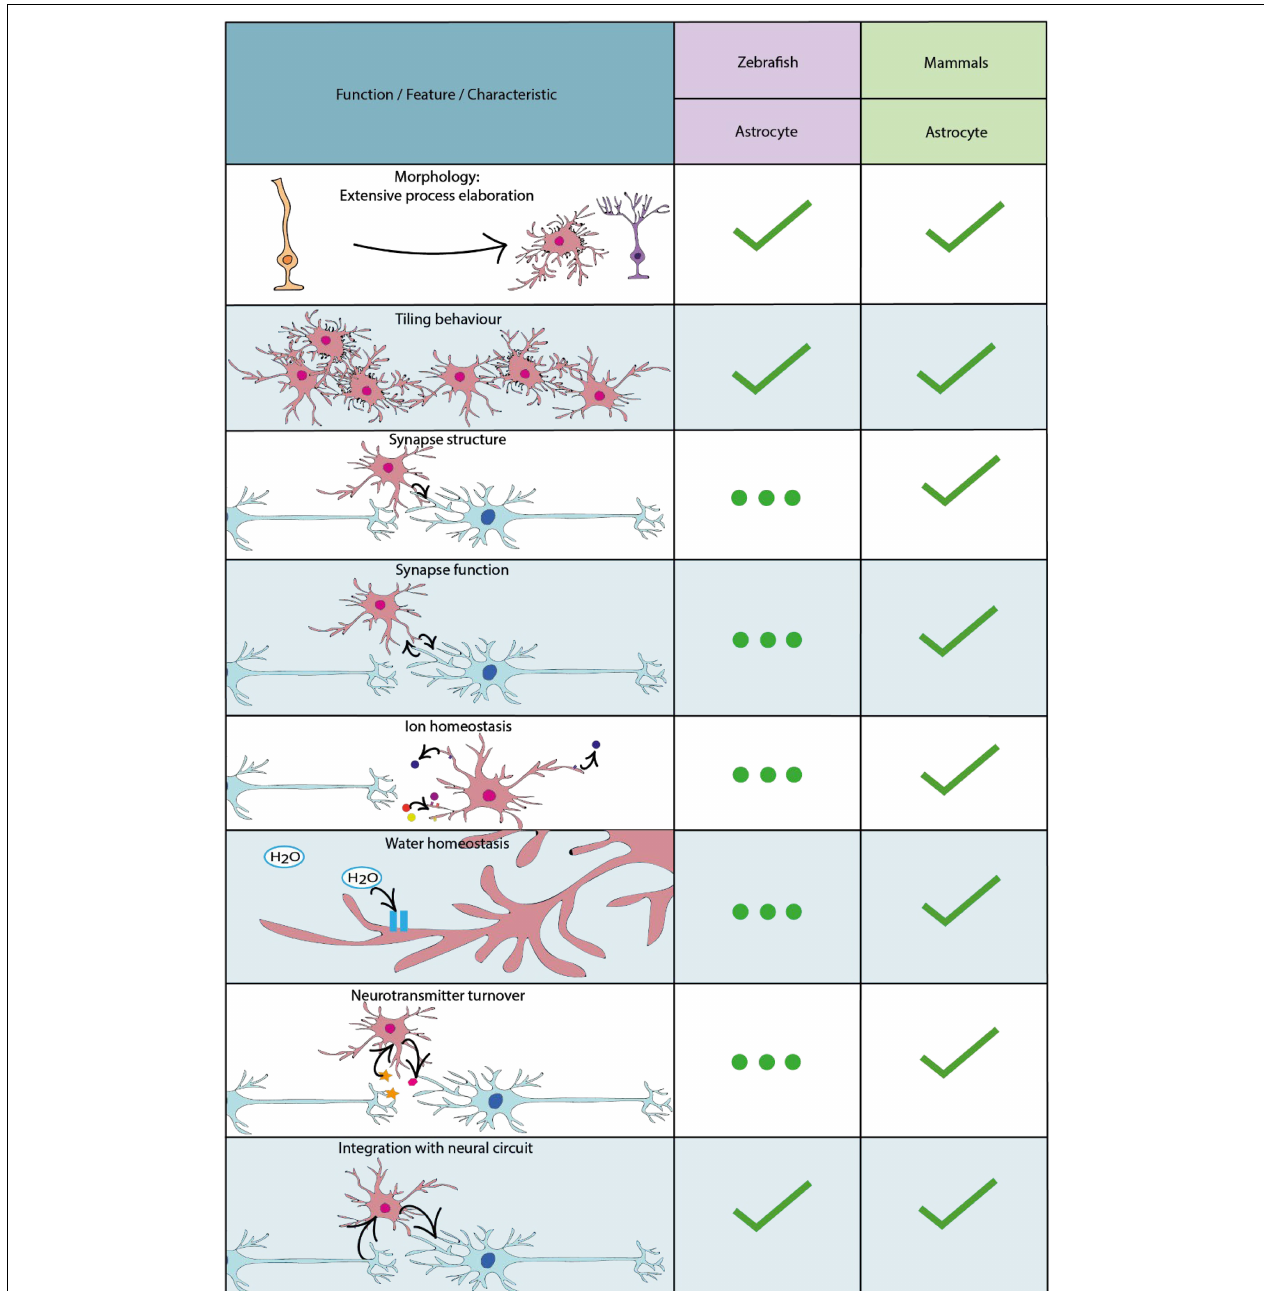
FIGURE 2 | Key characteristics and functional properties of zebrafish and mammalian astrocytes. For simplicity we refer to astrocytes as cells with a radial morphology, or those which have adapted a morphology akin to radial astrocytes. The use of “ ... ” refers to areas of astrocyte biology which require further